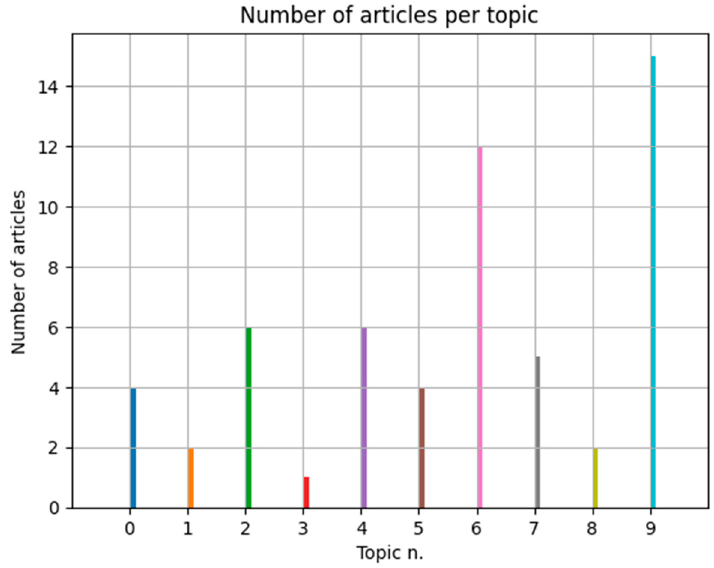
Figure 7. Distribution of articles per topic extracted via LDA.